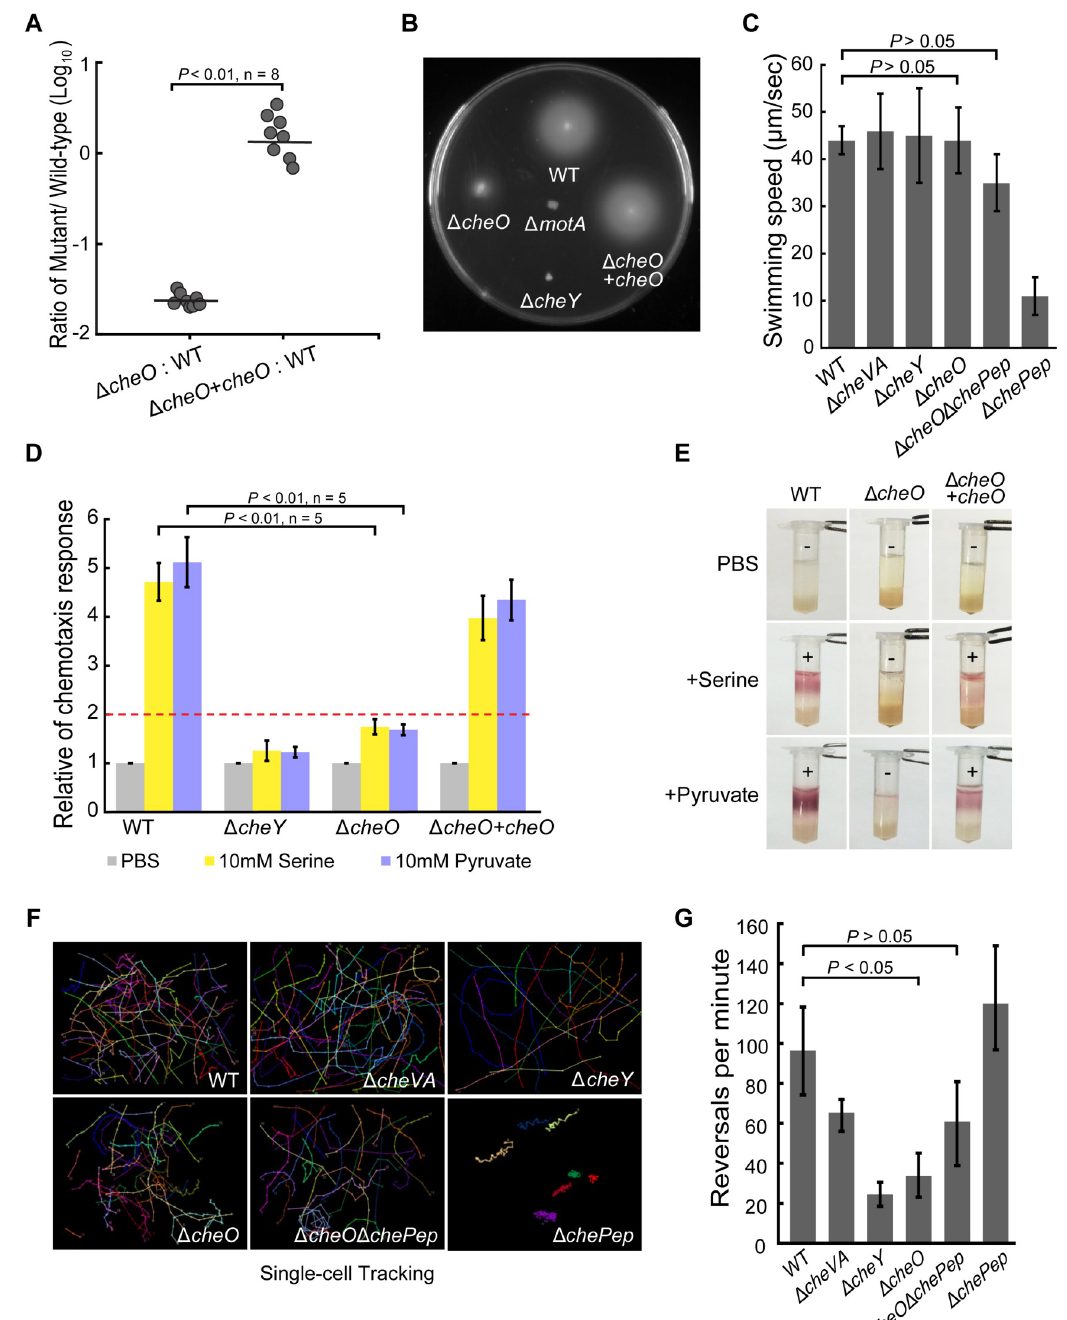
Fig 1. CheO affects C . jejuni chemotaxis. (A) Role of CheO in mouse colonization. Mice were inoculated with an equal number of wild-type C . jejuni and Δ cheO mutant or complemented mutant strains via oral gavage (n = 8). Ratio was calculated by the colony-forming units (CFUs) of the mutant over the CFUs of the wild-type strain recovered from the ceca of infected mice. Statistical significance was determined by a one-way ANOVA, P < 0.01. (B) Soft agar motility assay of C . jejuni wild-type and Δ cheO , Δ motA , Δ cheY mutants. (C) Quantification of swimming speed of C . jejuni wild-type, Δ cheVA , Δ cheY , Δ chePep , Δ cheO and Δ cheO Δ chePep mutants. Data are shown as mean ± SEM. The differences between Δ cheO mutants and wild-type were tested using Student’s t -test. (D) Capillary chemotaxis assay of C . jejuni wild-type and mutant strains. 10 mM serine or pyruvate in PBS solution serves as the chemoattractant and PBS buffer as a negative control. The histogram shows the relative chemotaxis response (RCR) of mutants relative to wild-type strain. RCR � 2 indicated a positive chemotaxis response. Data are shown as the mean ± SD (n = 5). P -